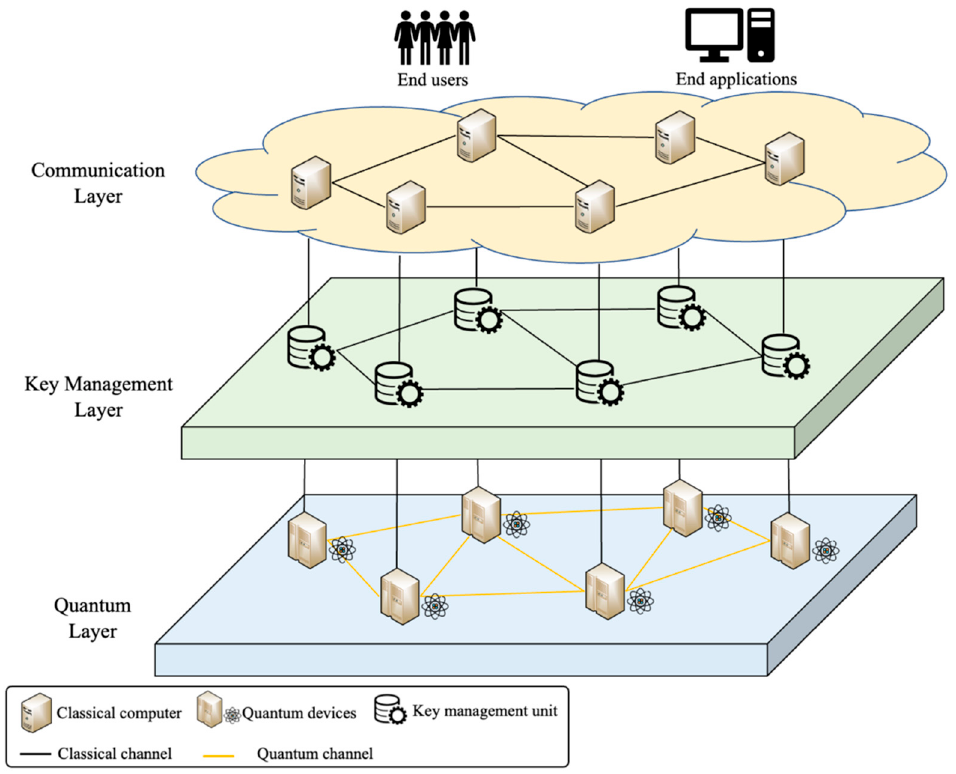
Figure 1. Framework of the quantum key distribution (QKD) network.